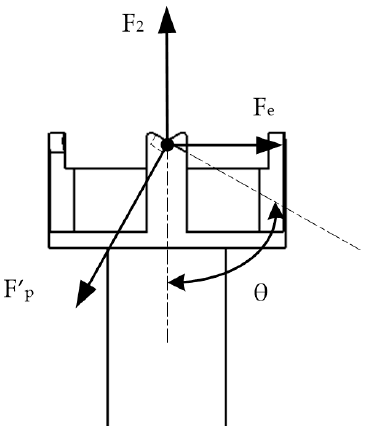
Figure 11 . Force diagram of cylindrical top rod.